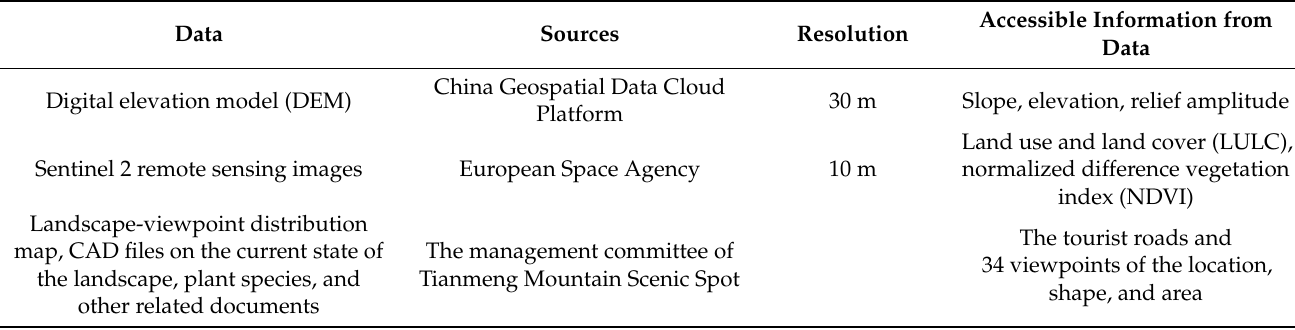
Table 1. Information on data sources.